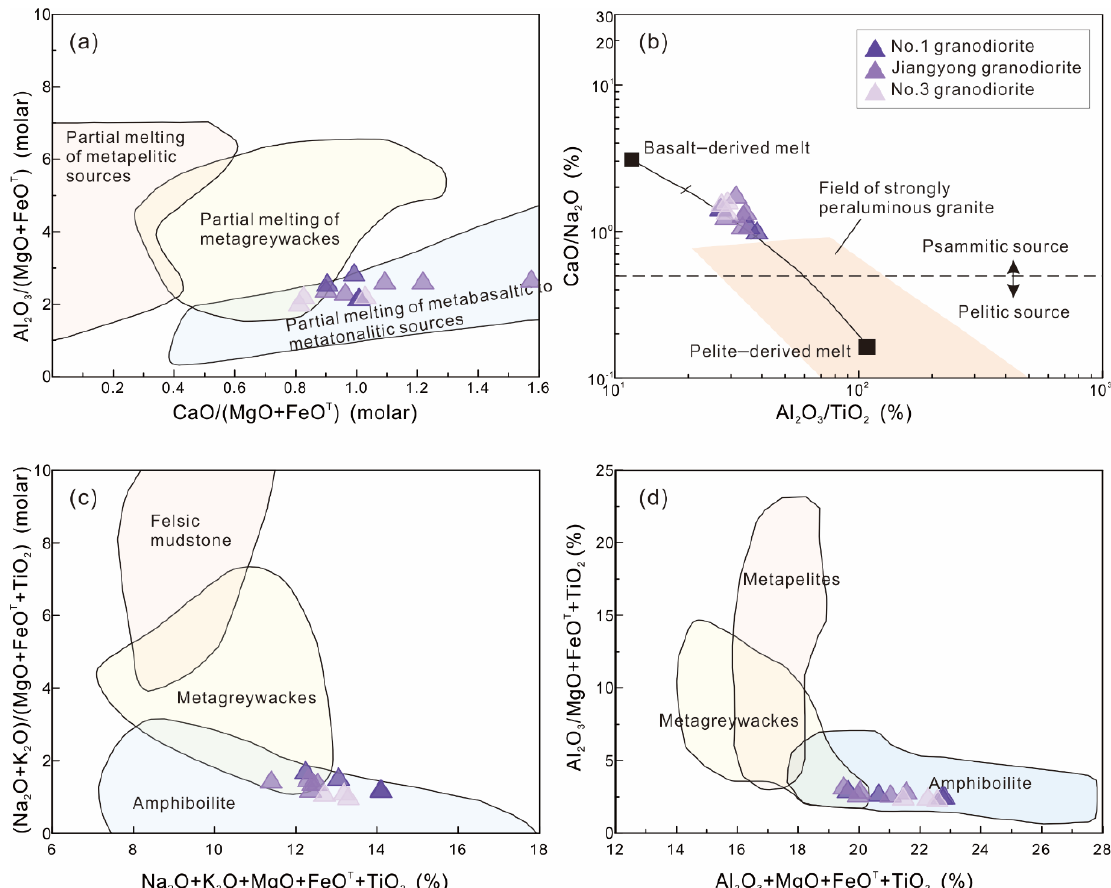
Figure 13. Plots of ( a ) molar CaO/(MgO + FeO T ) vs. molar Al 2 O 3 /(MgO + FeO T ), ( b ) Al 2 O 3 /TiO 2 vs. CaO/Na 2 O, ( c ) Na 2 O + K 2 O + MgO + FeO T + TiO 2 vs. molar (Na 2 O + K 2 O)/(MgO + FeO T + TiO 2 ), and ( d ) Al 2 O 3 + MgO + FeO T + TiO 2 vs. Al 2 O 3 /(MgO + FeO T + TiO 2 ) (( a ) is after [85]; ( b ) is after [79]; ( c , d ) are after